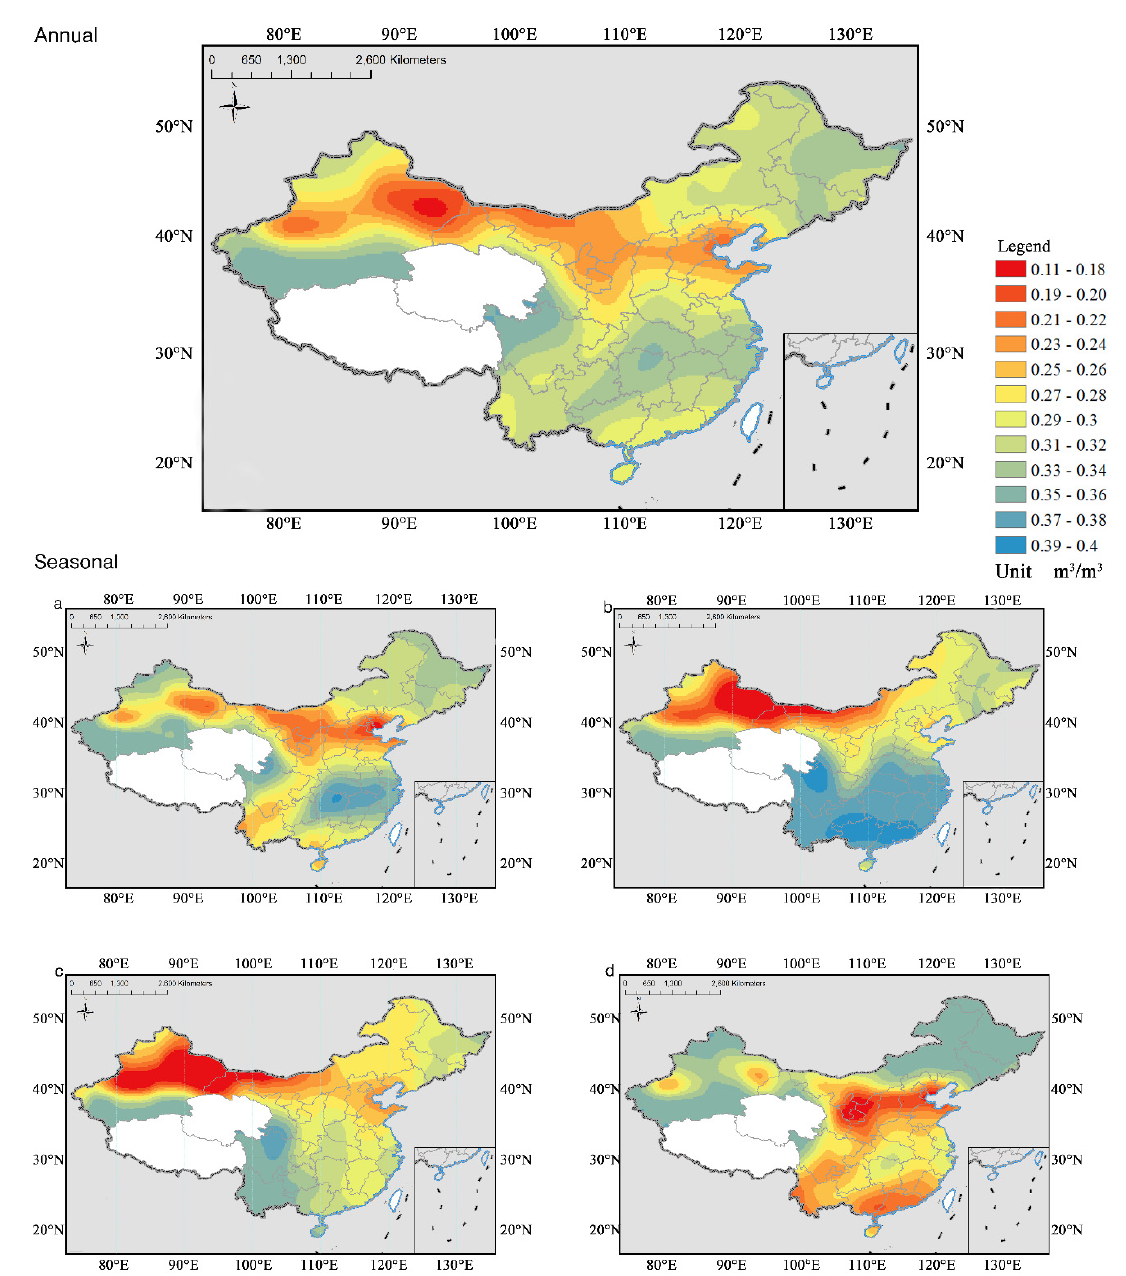
Figure 2. The distribution of annual soil moisture and seasonal soil moisture in China. ( a ) Spring; ( b ) summer; ( c ) autumn; ( d ) winter.